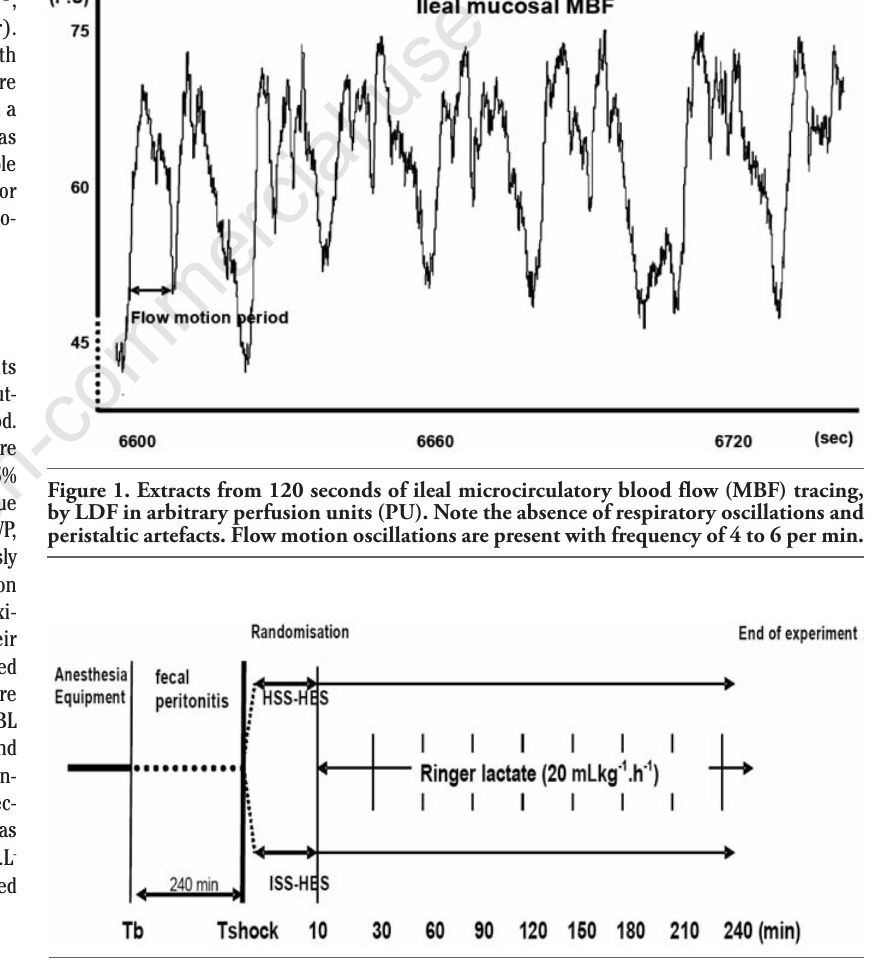
Figure 2. Experimental protocol. After the equipment of pigs, septic shock was induced by fecal peritonitis. Then animals were randomised into two groups to receive equal vol- umes of either hypertonic saline 7.2%/hydroxyethyl starch (HSS-HES) or isotonic saline 0.9%/hydroxyethyl starch (ISS-HES); Animals were observed for 240